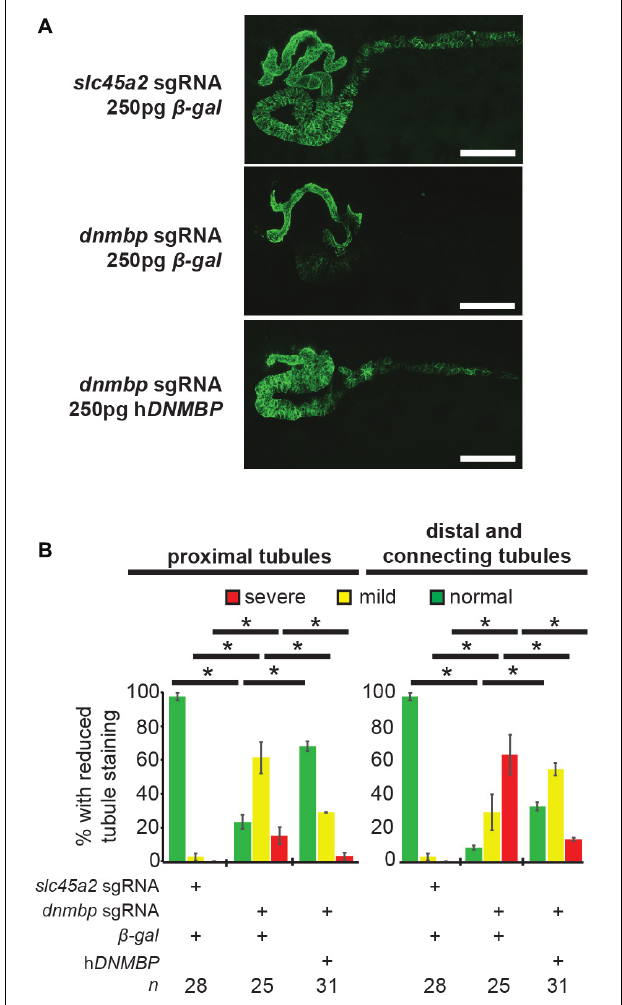
FIGURE 6 | Human DNMBP mRNA rescues kidney defects caused by CRISPR dnmbp knockout in Xenopus embryos. (A) Representative embryos showing that co-injection of β -galactosidase RNA with a sgRNA against dnmbp does leads to kidney defects in comparison to control embryos injected with a sgRNA against slc45a2 and β -galactosidase RNA. Co-injection of human DNMBP mRNA with a sgRNA against dnmbp rescues the knockdown phenotype. Stage 40 embryos stained with antibody 3G8 to label the proximal tubule and antibody 4A6 to label the distal and connecting tubules. White bar is 200 µ m. (B) Quantitation of the rescue phenotype. n = number of embryos across 2 replications. Error bars represent Standard error. ∗ Significantly different, p <